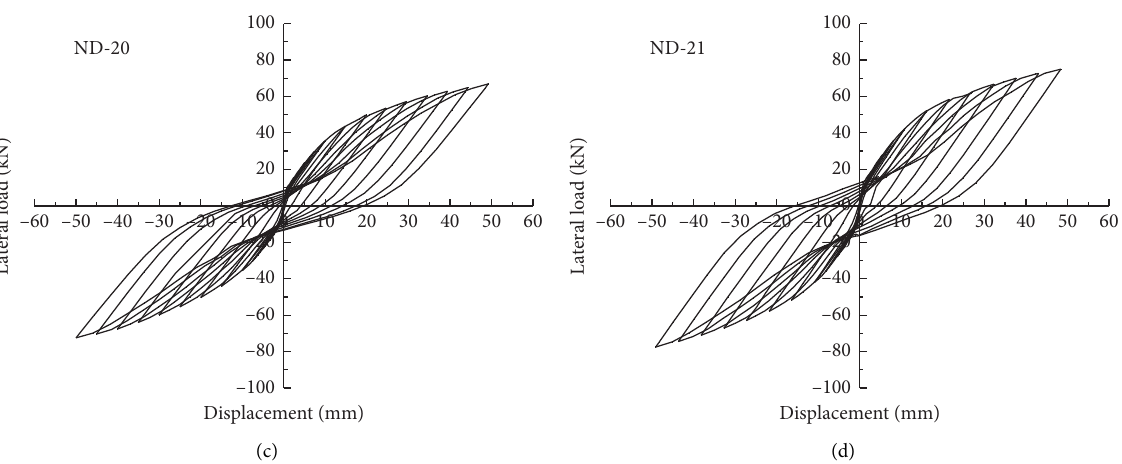
Figure 22: Hysteretic curves of slit width 200mm. (a) 30MPa. (b) 40MPa. (c) 50MPa. (d) 60MPa.